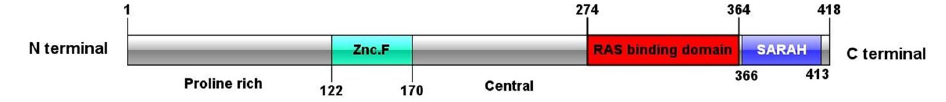
Figure 1. Protein structure of RASSF5 (adapted and modified from Shuofeng et al. 2018 83 ).